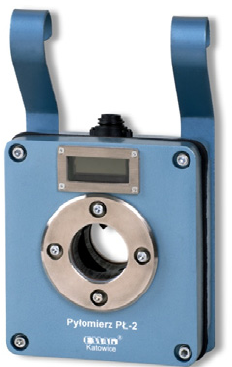
Figure 6. The PŁ-2 optical dust meter used in